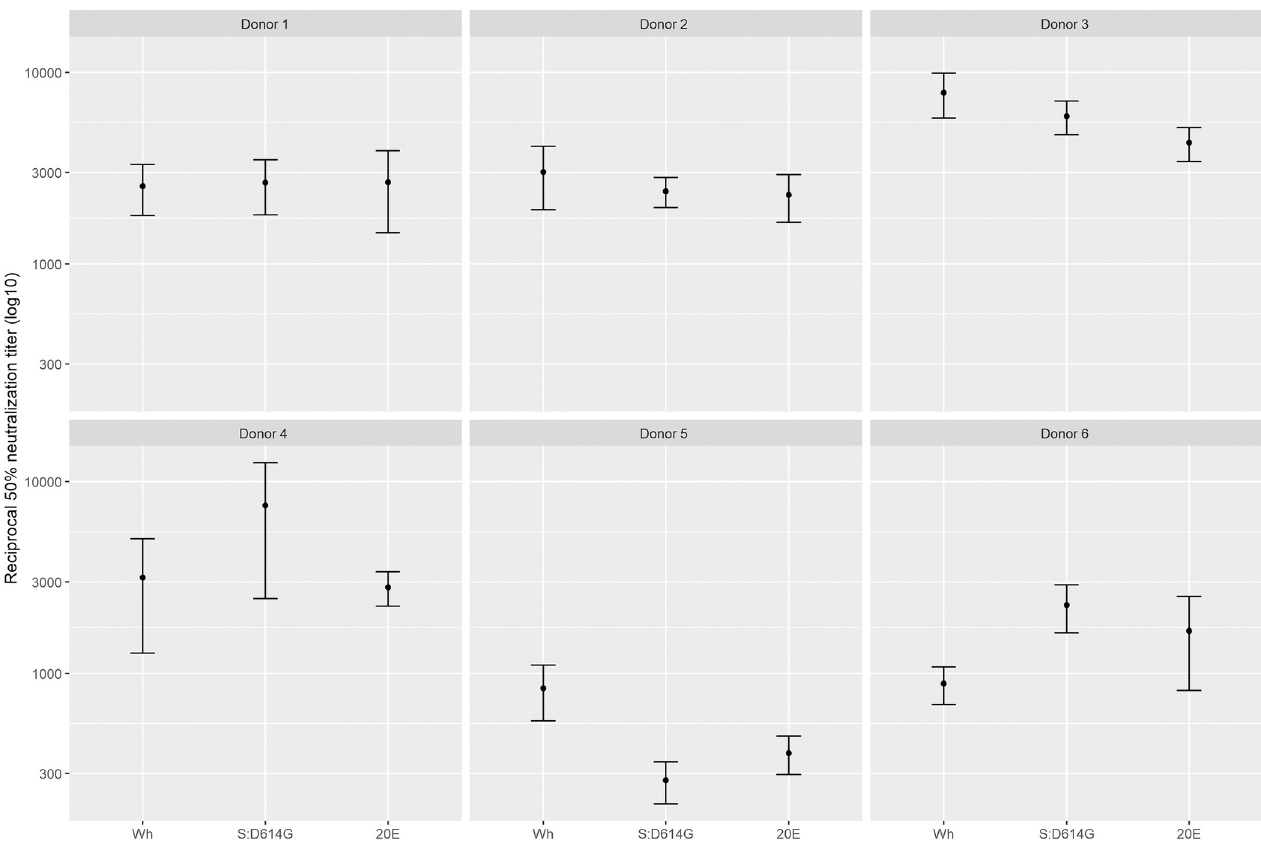
Fig 3. S:A222V does not alter the neutralization capacity of convalescent sera. The sensitivity to neutralization by convalescent sera of pseudotyped VSV carrying the ancestral Wuhan-Hu-1 (Wuhan), S:D614G, or the [S:A222V + S:D614G] (20E) spike protein was evaluated. No significant differences were detected between any of the sera (n = 6; p > 0.05 by Kruskal-Wallis test; p > 0.05 by Mann-Whitney test for Wuhan-Hu-1 vs. S:D614G, Wuhan-Hu-1 vs. 20E, or S:D614G vs. Wuhan-Hu-1).